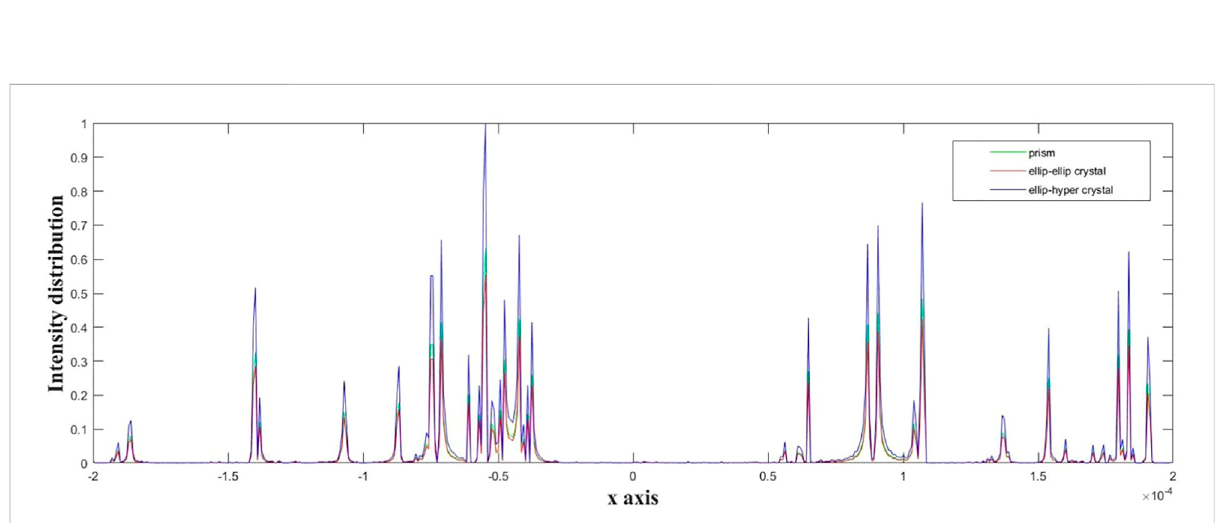
FIGURE 9 Light intensity distribution at y (cid:2) 0 axis based on different